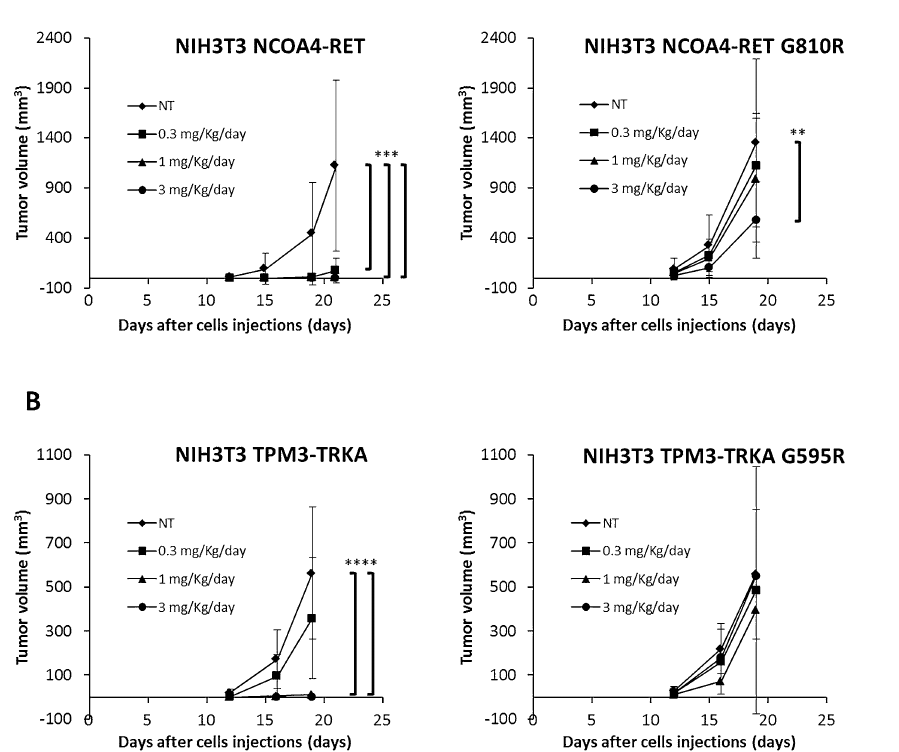
Figure 7. The indicated RET- and TRKA-transformed NIH3T3 cells were inoculated subcutaneously into both flanks of nu/nu mice. After four days, mice were randomly assigned to receive Pz-1 (0.3, 1 or 3 mg/Kg) by oral gavage or left untreated. Average size ± SD of tumours is